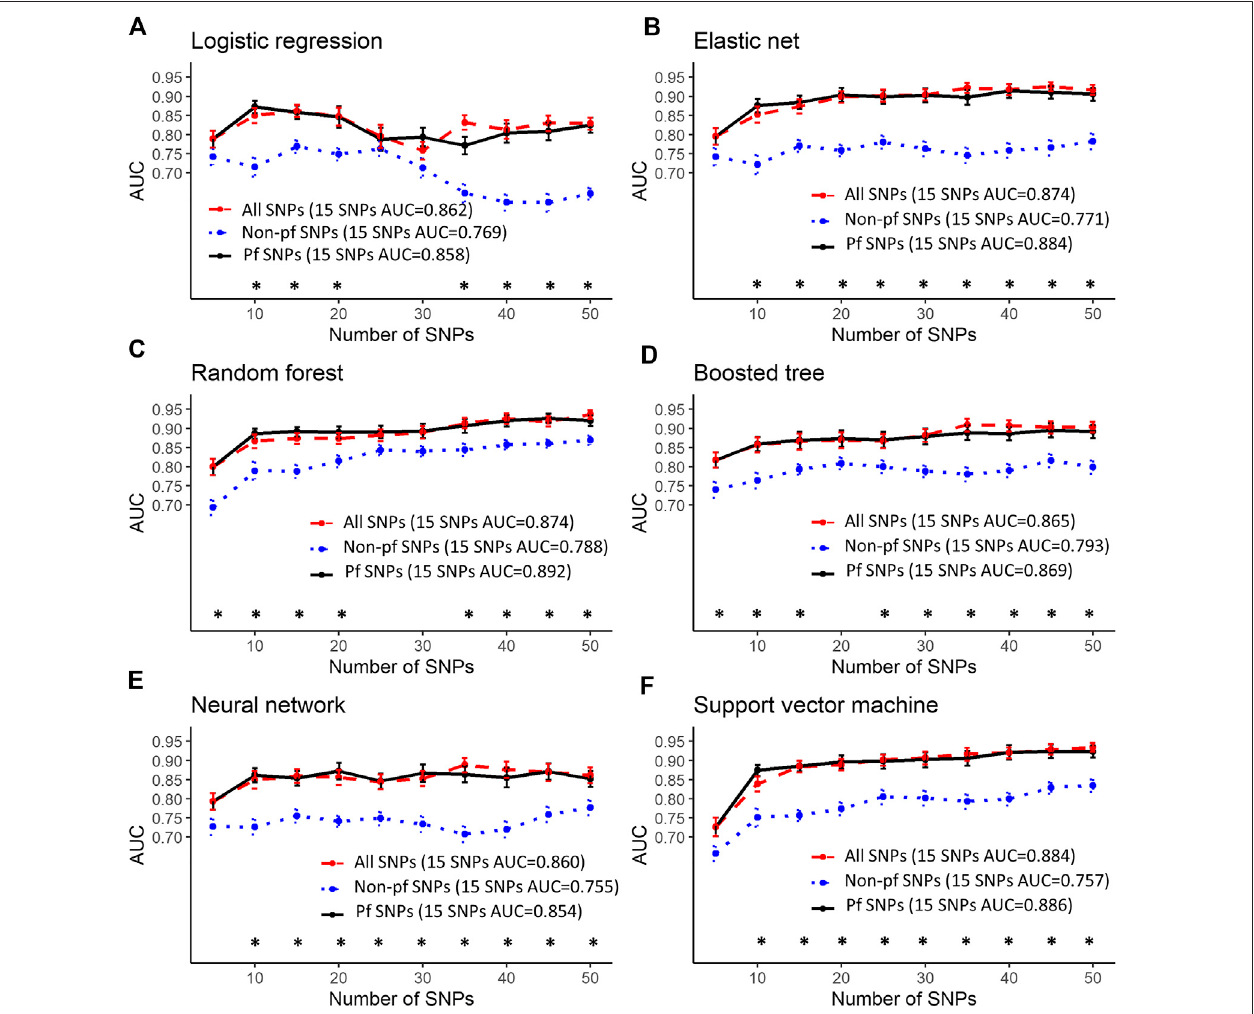
FIGURE 3 | Predictive performance using the top 5 – 50 SNPs in atorvastatin pathway genes. Error bars denote the standard error of the mean. # ’ s indicate statistical signi fi cance when comparing between all SNPs and pfSNPs while * ’ s indicate statistical signi fi cance when comparing between non-pf SNPs and pfSNPs. Statistical signi fi cance when comparing between all SNPs and non-pfSNPs is not shown. The colors represent the input set with the higher AUC (red — all SNPs, blue — non-pf SNPs and black — pfSNPs). Bonferroni corrected unpaired t -test p -values ( p < 0.05) were used for determining statistical signi fi cance.